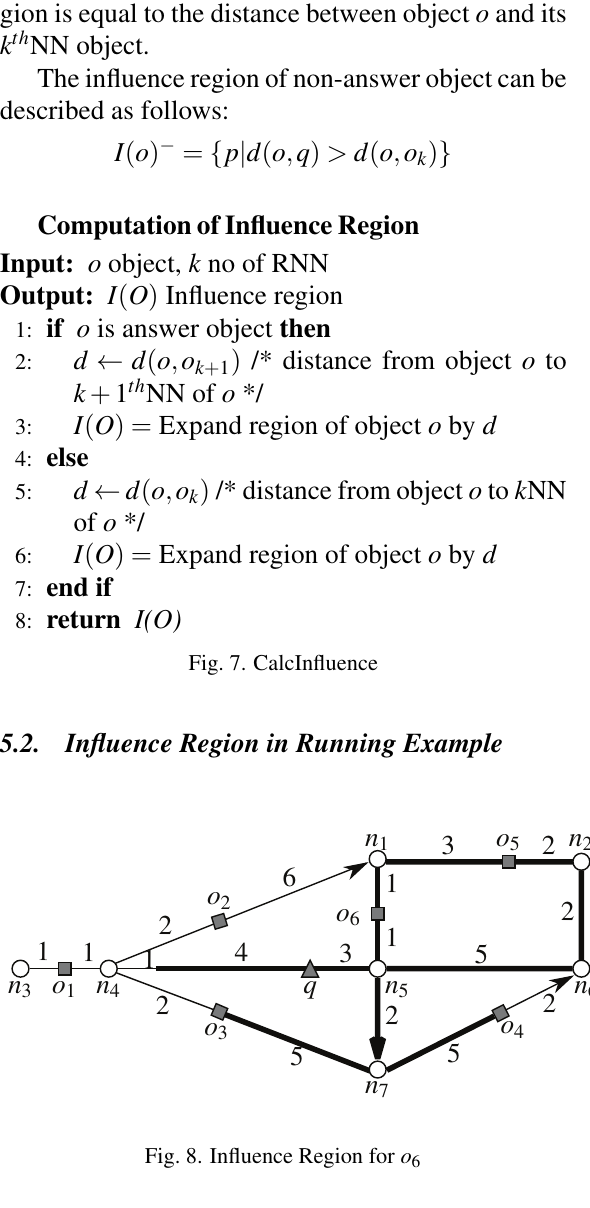
Fig. 8. Influence Region for o 6 In Fig. 3a object o 6 is an answer object and 2NNs of o 6 = ( q , o 5 ) where d ( o 6 , q ) = 3 and d ( o 6 , o 5 ) =